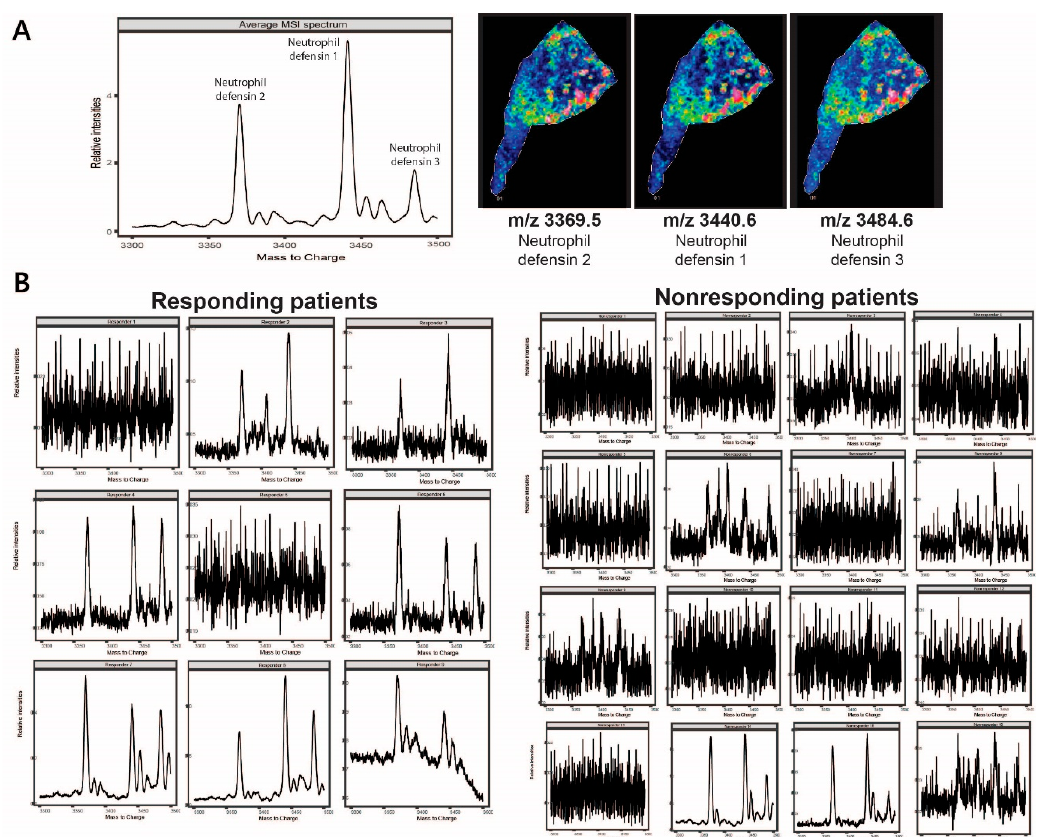
Figure 3. Average MALDI MSI spectra obtained from whole formalin-fixed paraffin-embedded (FFPE) tumor biopsies of NSCLC patients. ( A ) An example of a resulting average mass spectrum with neutrophil defensin 1, 2 and 3 and their corresponding distribution within the tissue, obtained with MALDI MSI analysis on a FFPE tissue section; ( B ) Average MALDI MSI spectra of 25 pretreatment tumor FFPE biopsies from NSCLC patients that received anti-PD-(L)1 immunotherapy. From this small patient cohort, nine patients received clinical benefit from the therapy (responders), from which seven patients showed expression of the neutrophil defensins. The other 16 NSCLC patients did not derive any clinical benefit from immunotherapy treatment (nonresponders), from which 14 show no (or very low) neutrophil defensin expression. From the nonresponding patients, two NSCLC patients showed neutrophil defensin expression .